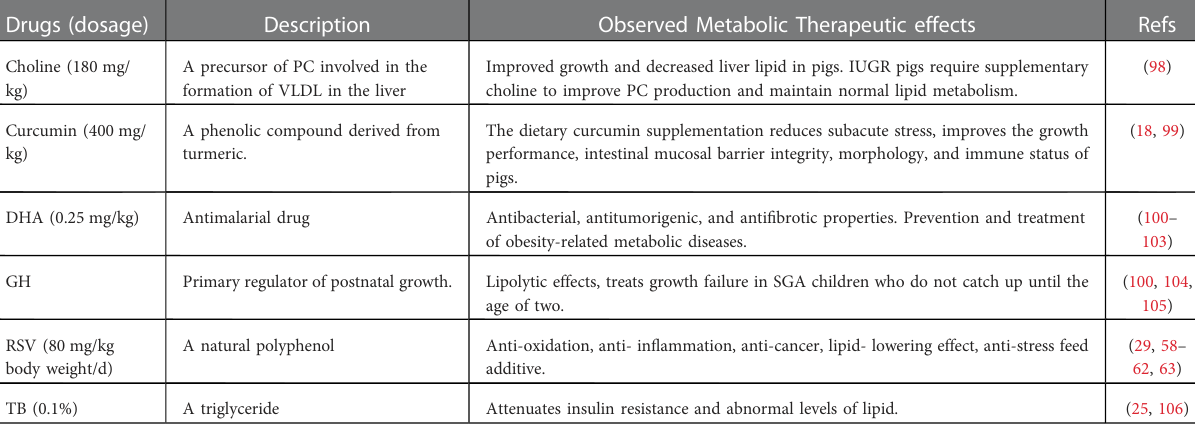
TABLE 1 Intrauterine growth restriction preclinical experimentation. Drugs (dosage)